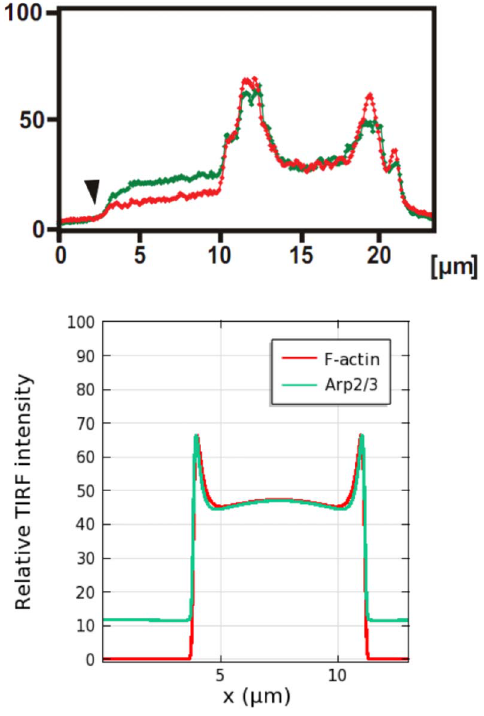
Figure 7. Localization of F-actin (red) and Arp2/3 (green) in actin waves. TIRF intensity along a line scan shows the relative localization of F-actin and Arp2/3 near the contact surface. (Upper) Experimental observation from [21]. (Lower) Simulation on a